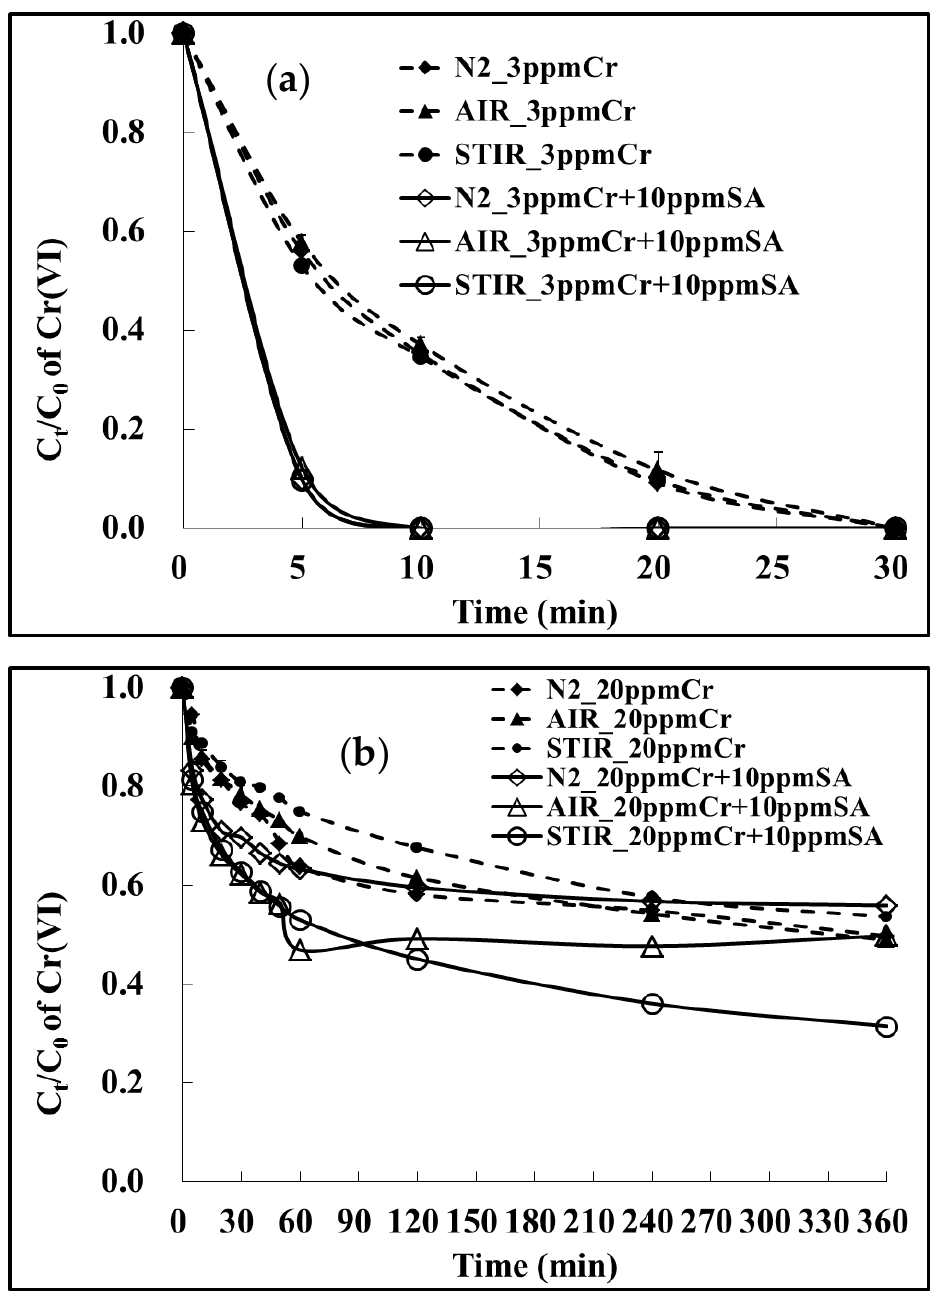
Figure 4. Effects of oxygen on residuals of Cr(VI) after photo-reduction by TiO 2 ( a ) Cr 3 mgL −1 and ( b ) Cr 20 mgL −1 .